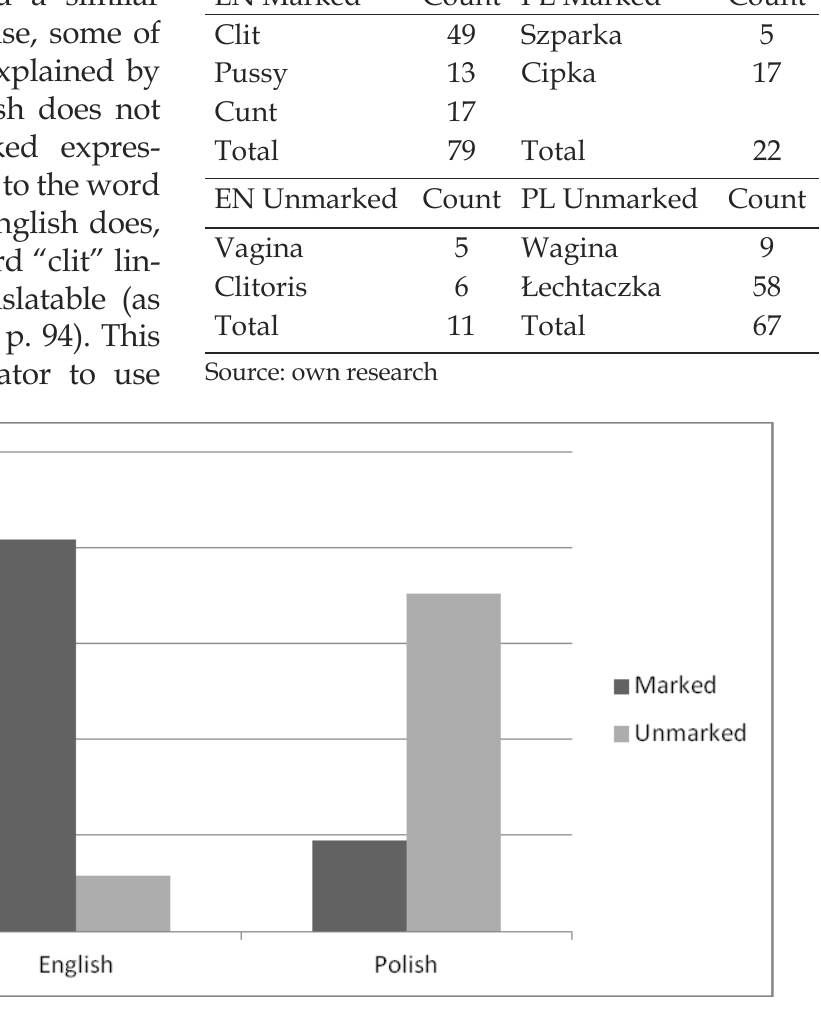
The comparison of the distribution of marked and unmarked vocabulary items related to male and female genitals in source and target texts Source: own